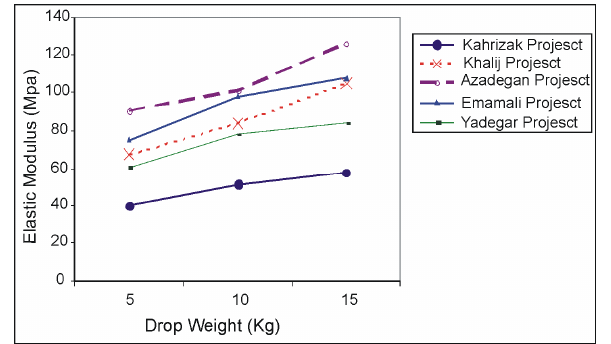
Fig. 3. Effect of drop weight on PFWD moduli Fig. 4. Correlation between measured and calculated